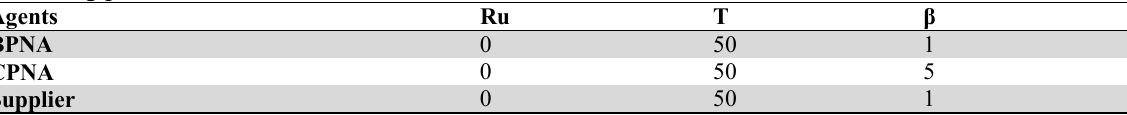
Conceding parameters